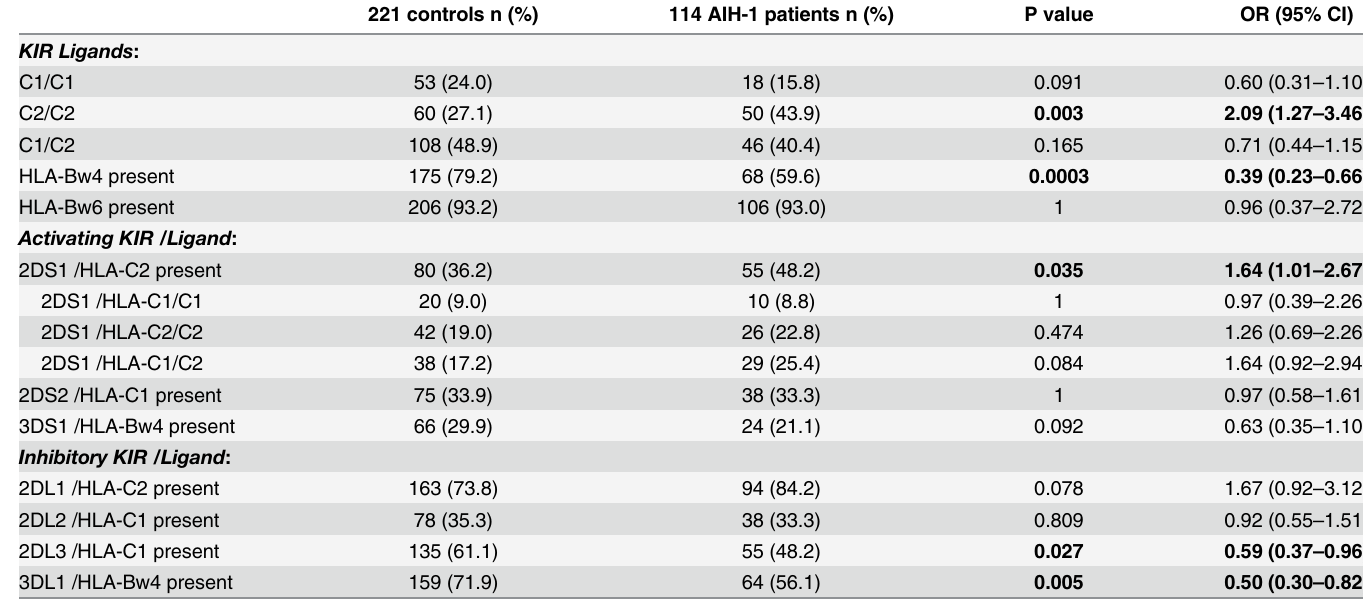
Table 4. Comparisons of KIR ligands and combinations of KIR-HLA ligands between patients with type 1 autoimmune hepatitis and controls. 221 controls n (%) 114 AIH-1 patients n (%) P value OR (95%